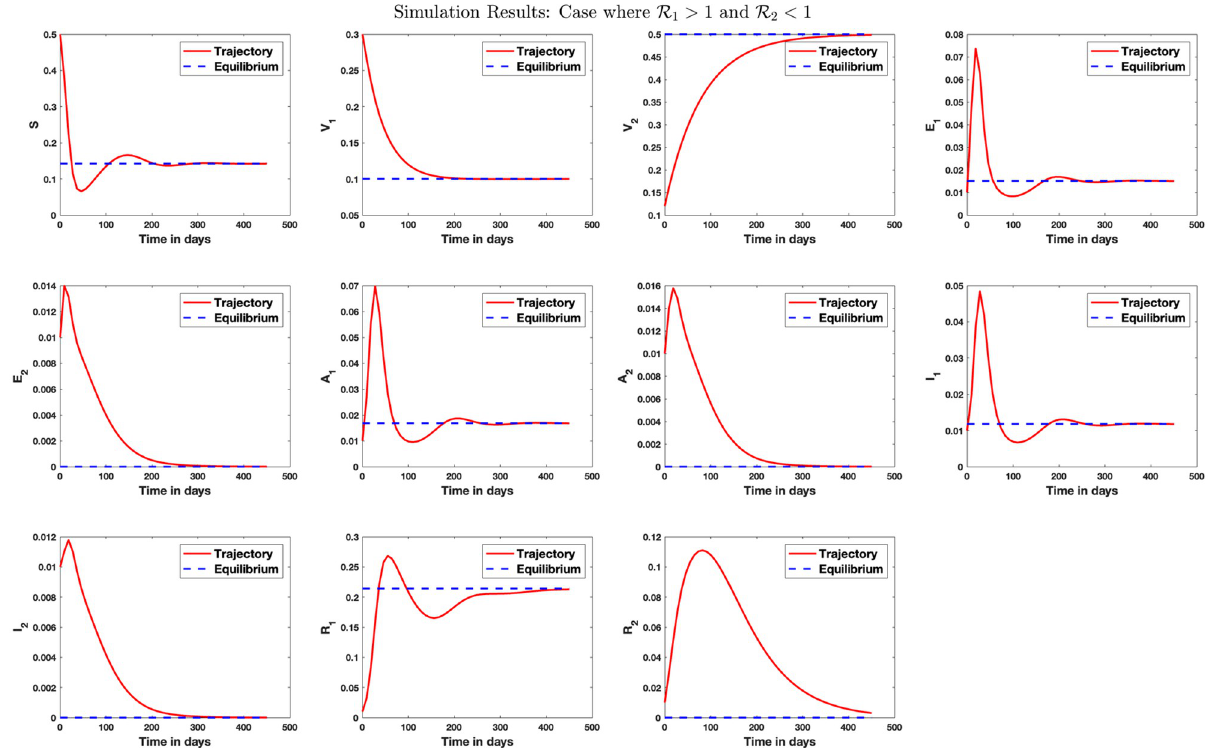
Fig 4. Stability analysis for the strain 1 equilibrium. Case where R 80.3, q 1 = 0.1, q 2 = 0.5, λ 1 = 1/5, λ 2 = 1/4, r 1 = 1/10.5, r 2 = 1/9, θ 1 = 0.09, θ 2 = 0.1. A scenario where the population of those receiving vaccination against strain 1 (with high transmission rate) dropped, leading to strain 1 endemic. In this case, R equilibrium is obtained as E ¼ f 0 : 1422 ; 0 : 1000 ; 0 : 5000 ; 0 : 0151 ; 0 ; 0 : 0168 ; 0 ; 0 : 0118 ; 0 ; 0 : 2141 ; 0 g : 1